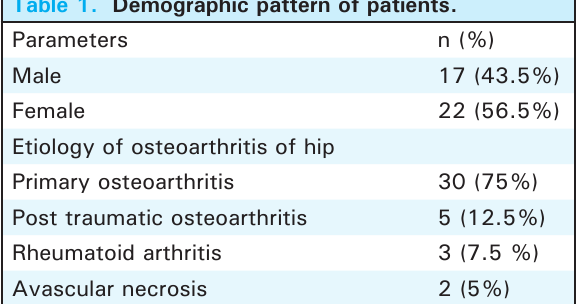
Table 1. Demographic pattern of patients.